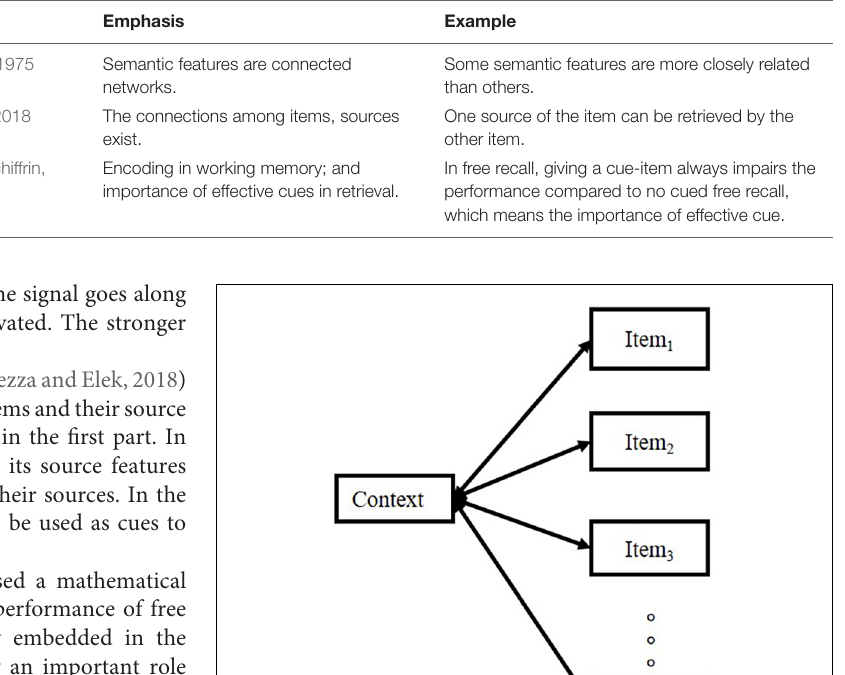
TABLE 1 | Old models that emphasize different connections in memory.